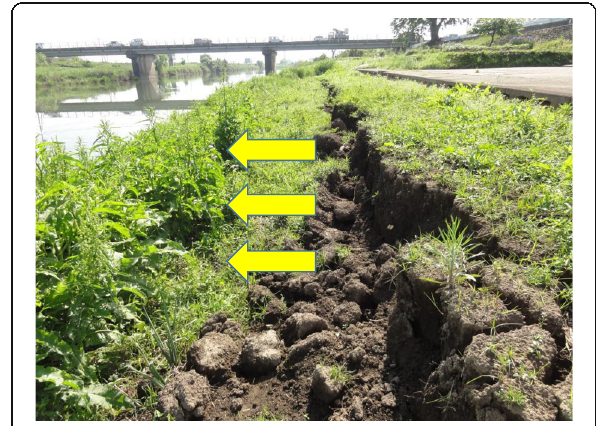
Fig. 9 The tilt condition of the house in Akitsu after the earthquake struck Fig. 10 The occurrence of lateral spreading at the river side,